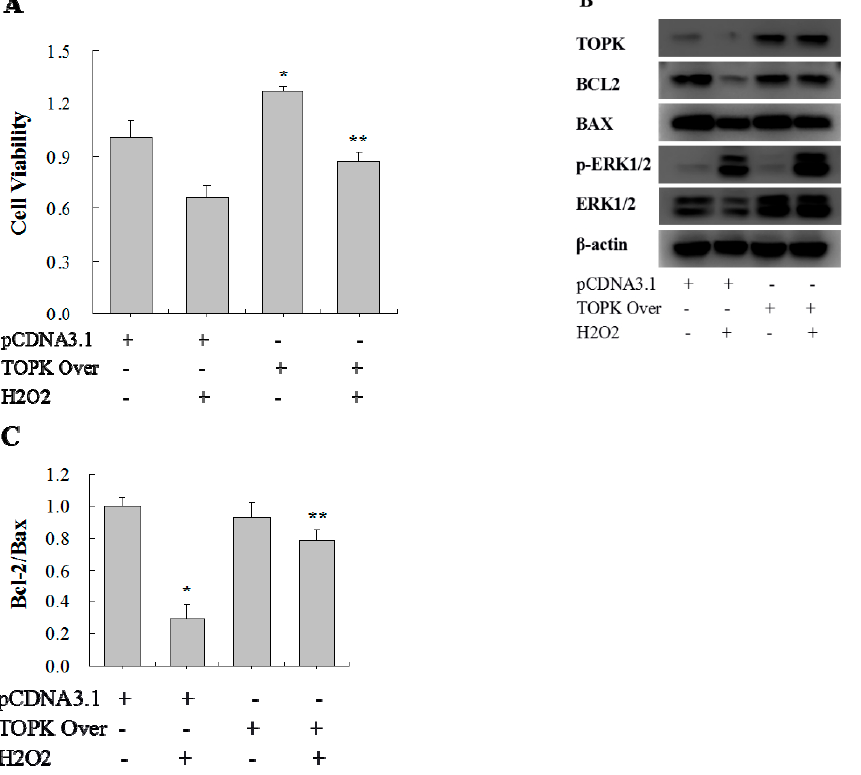
Figure 5. Analysis of the effects of TOPK overexpression on cell viability, apoptosis, and protein expression. H9C2 cardiomyocytes were stimulated with 750 µM of H 2 O 2 for 1 h after TOPK overexpression plasmid/empty plasmid transfection for 72 h. ( A ) Cell viability as detected by MTS assay; ( B ) Western blot analysis of Bcl-2, Bax, ERK, and p-ERK expression. β -actin was used as a loading control; ( C ) Comparison of the Bcl-2/Bax ratio. * p < 0.05 compared with nonstimulated controls with empty plasmid transfection; ** p < 0.05 compared with H 2 O 2 -stimulated controls with empty plasmid transfection.